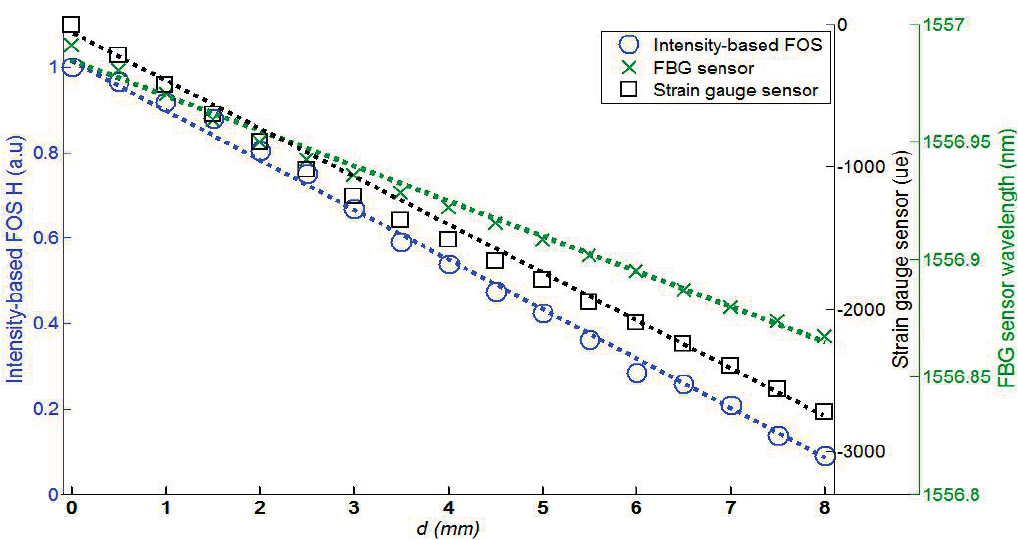
Figure 8. Measured data of FRP coupon strain with three types of sensors ( d : displacement in Figure